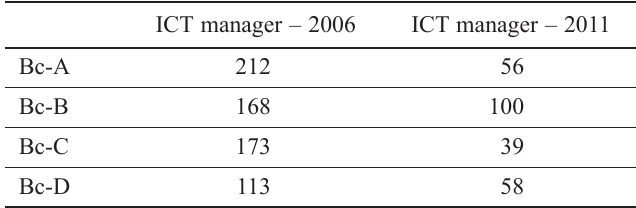
Table 11. Distance between the requirements of economic